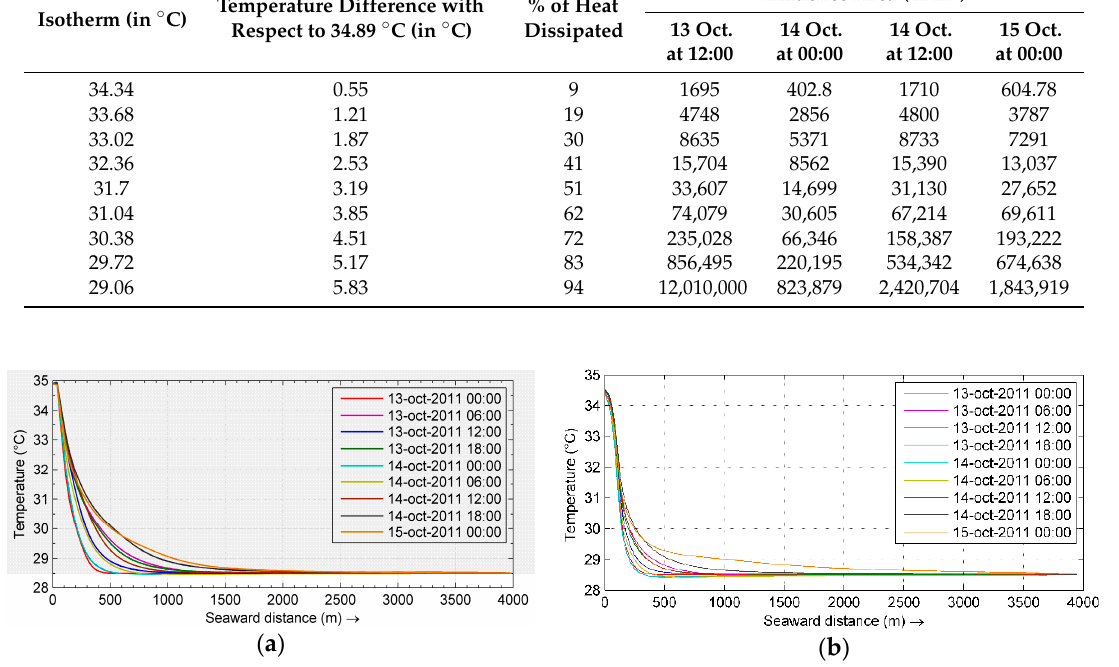
Figure 14. Decay curves of temperature following the discharge axes. ( a ) Discharge 1; ( b ) Discharge 3.